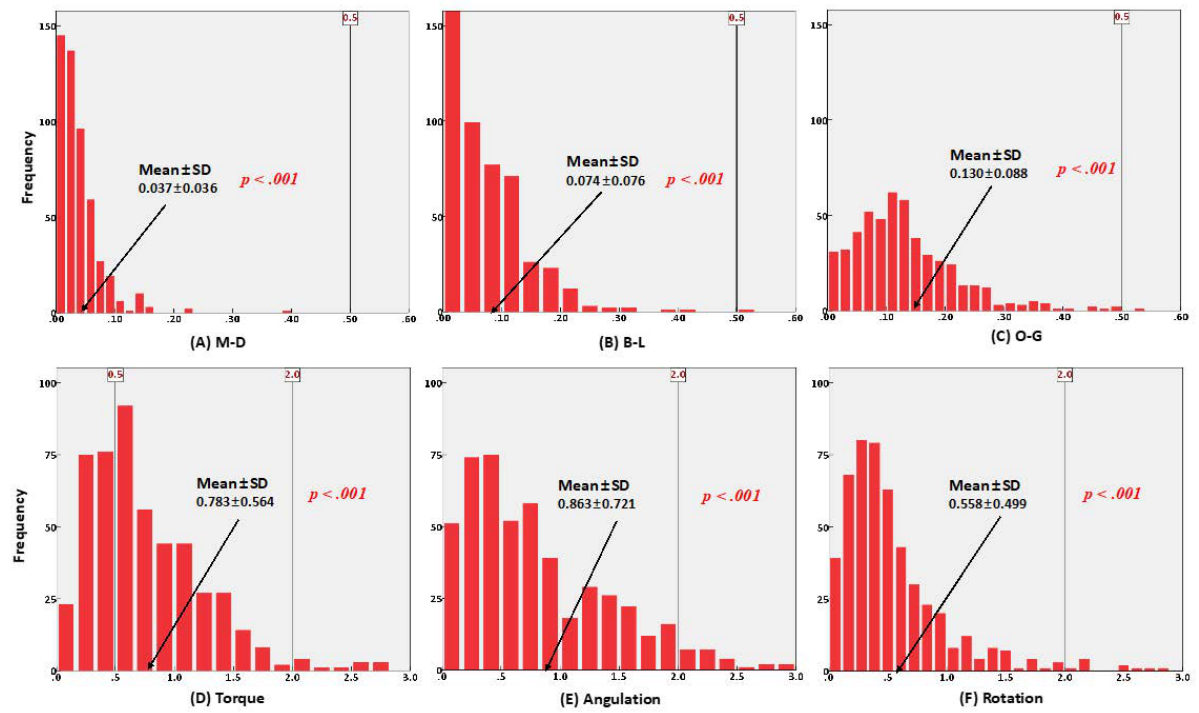
Figure 8. Histogram of frequencies for six measurements with one-tailed equivalence test in group A. ( A – C ) linear measurements, ( D – F ) angular